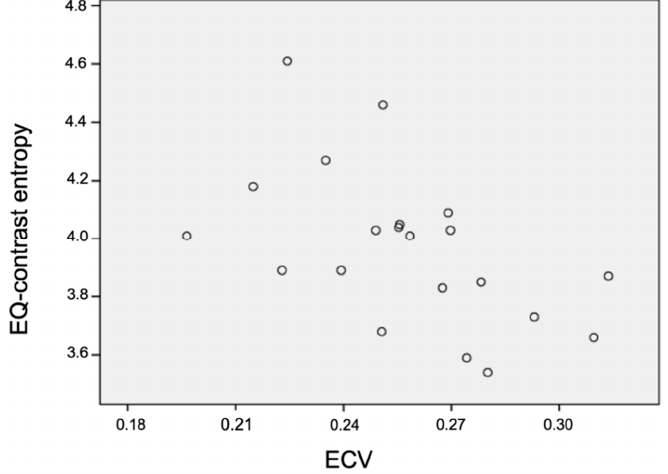
Figure 8. Scatter plot demonstrating correlation between EQ-contrast entropy versus ECV in whole liver coarse (SSF: 6 mm) texture analysis (r s = -0.58, p = 0.006). EQ: equilibrium, ECV: extracellular volume, and SSF: spatial scale filter.